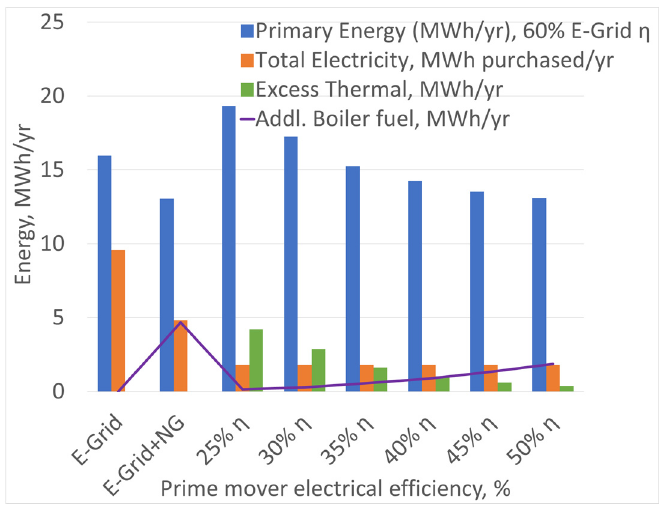
Figure 5. Energy performance analysis of cogeneration system-based configurations with different prime power electrical efficiencies. Combined load of 28 kWh/day, 0.5 kW PV, 0.4 kW PM, and 2 kWh electrical storage capacitance.